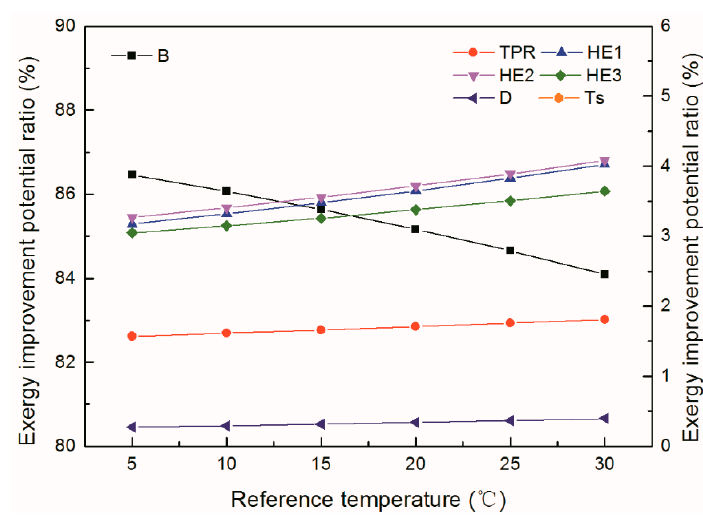
Figure 11. Effect of reference temperature on exergy improvement potential of major components.